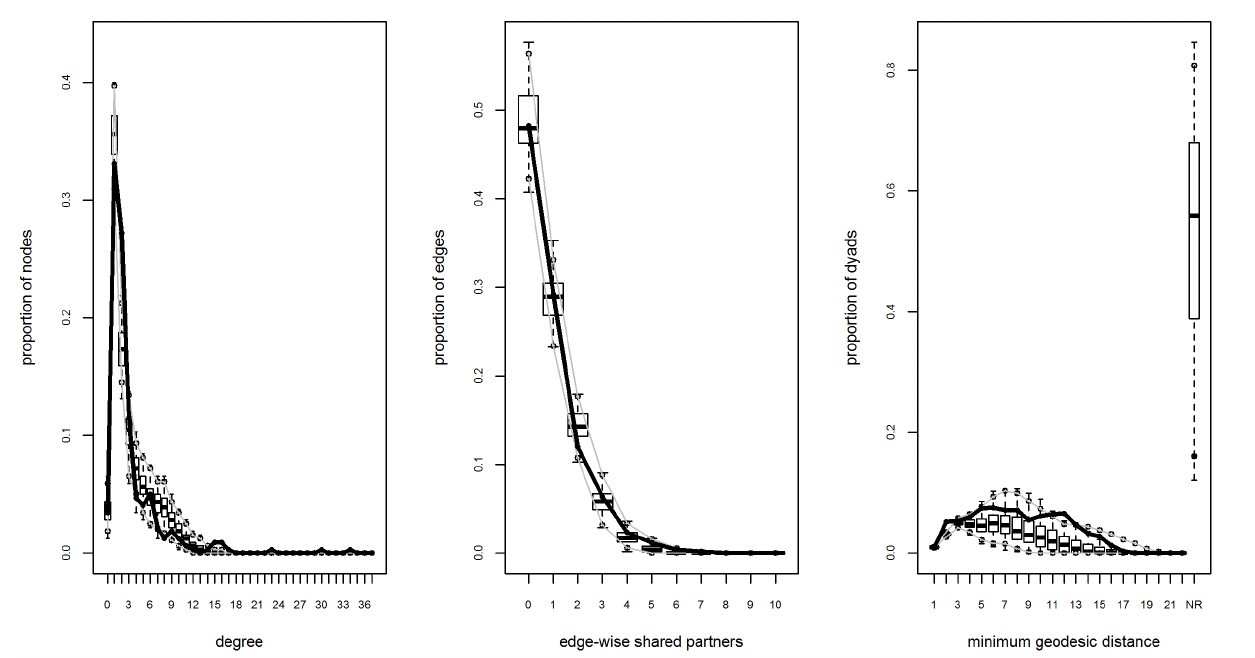
Figure A3.1: GOF plots for the local-level